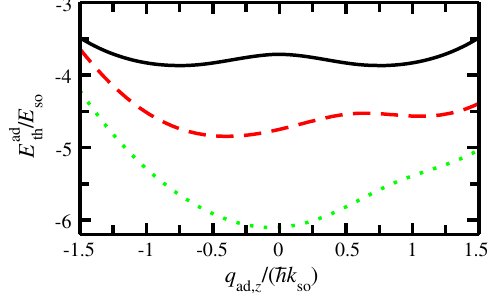
FIG. 6. Relative atom-dimer dispersion curves for ð a 0 . 01128 and Ω =E ¼ 2 . The solid, dashed, and dotted lines show so the energy E ad as a function of the z component q th ˜ δ ¼ 0 , 2.287, and 3.5, =E dimer momentum for so